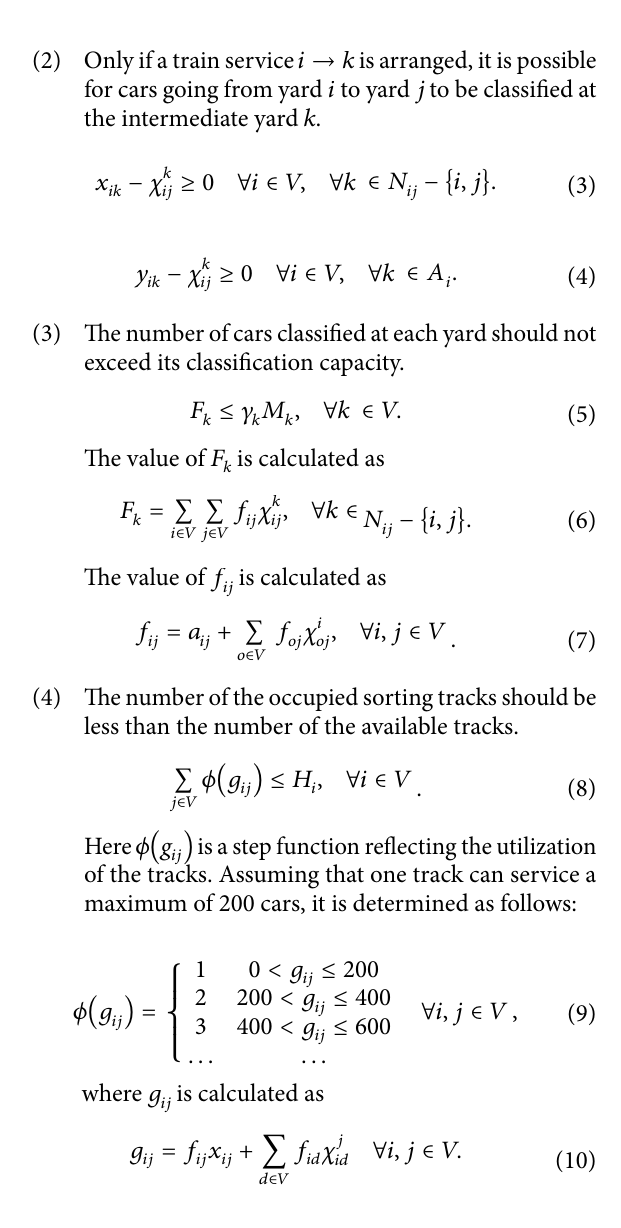
Figure 4: A 21-yard railway